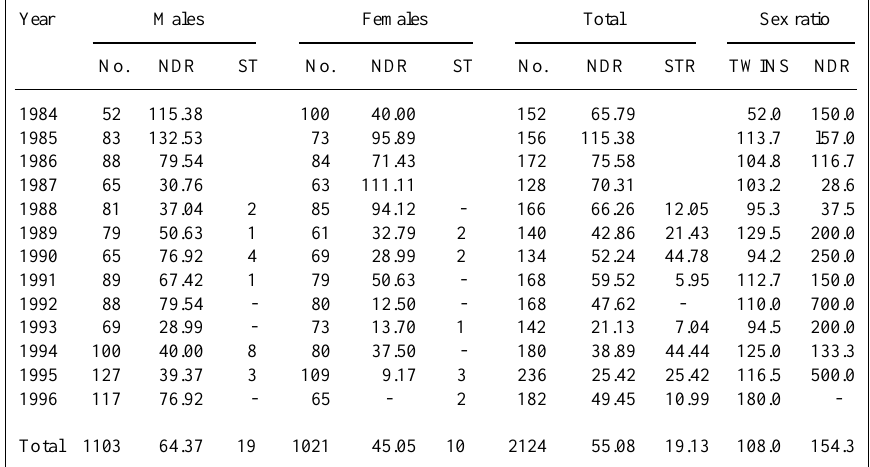
Table II - Early neonatal death rate per 1,000 (NDR) from 1984 to 1996, number of stillbirths (ST) and stillbirth rate per 1,000 (STR) from 1988 to 1996 among twins born at the Maternidade de Campinas. The sex ratios (number of males per 100 females) of all newborn co-twins and of those who died in the first week (ND) are also shown.